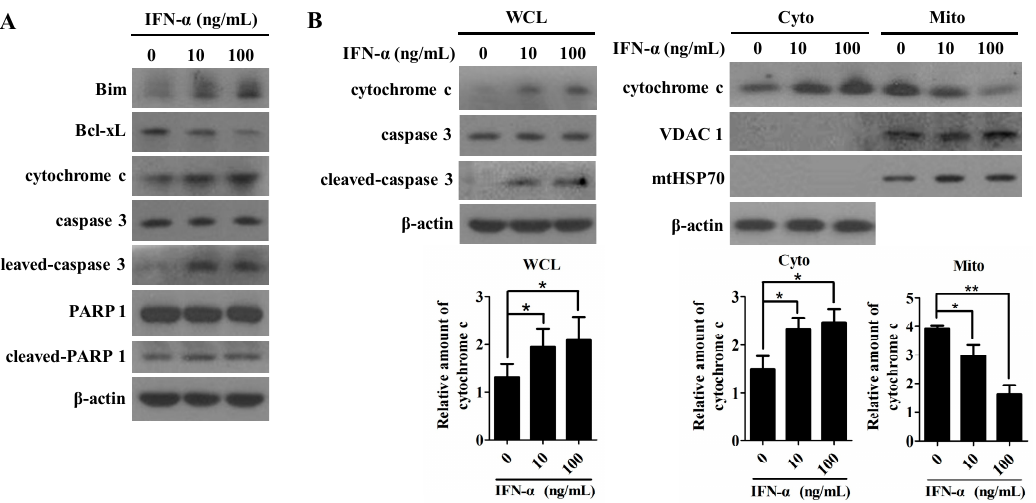
Figure 3. IFN- α -mediated cell apoptosis in HeLa cells is associated with the mitochondrial-mediated intrinsic pathway. ( A ) Western blot analysis of the expressions of the key mediators associated with the intrinsic apoptotic pathway. HeLa cells were treated with IFN- α for 48 h. The whole-cell lysates (WCL) were prepared and probed with anti-Bim, anti-Bcl-xL, anti-caspase 3, anti-cleaved-caspase 3, anti-cytochrome c, anti-PARP1 (poly (ADP-ribose) polymerase 1), and anti-cleaved-PARP1 antibodies. The reaction products were subjected to Western blot analysis. The β -actin gene expression is served as an internal control; ( B ) IFN- α promotes cytochrome c release from mitochondria into cytosol in HeLa cells. Mitochondrial (Mito) and cytoplasmic (Cyto) proteins were separated using a mitochondria isolation kit. The whole-cell lysates (WCL) were probed with anti-cytochrome c, anti-caspase 3, and anti-cleaved-caspase 3 antibodies, while the mitochondrial and cytoplasmic lysates were probed with anti-cytochrome c, anti-VDAC1 (voltage-dependent anion channel 1), and anti-mtHSP70 (mitochondrial heat shock protein 70) antibodies. The β -actin gene expression is served as an internal control for cytosol. VDAC1 served as a mitochondria loading control. mtHSP70, a mitochondria matrix-specific protein, was included to monitor the quality of the mitochondrial isolation. The diagram at the lower panel represents the relative amounts of cytochrome c in different cell compartments (WCL, Mito, or Cyto) after IFN- α treatment, which were quantitated based on the expressions of either β -actin or VDAC1 from three independent assays using the Image J program. After statistical analysis, results were considered to be significant if p < 0.05 (*) or p < 0.01 (**).